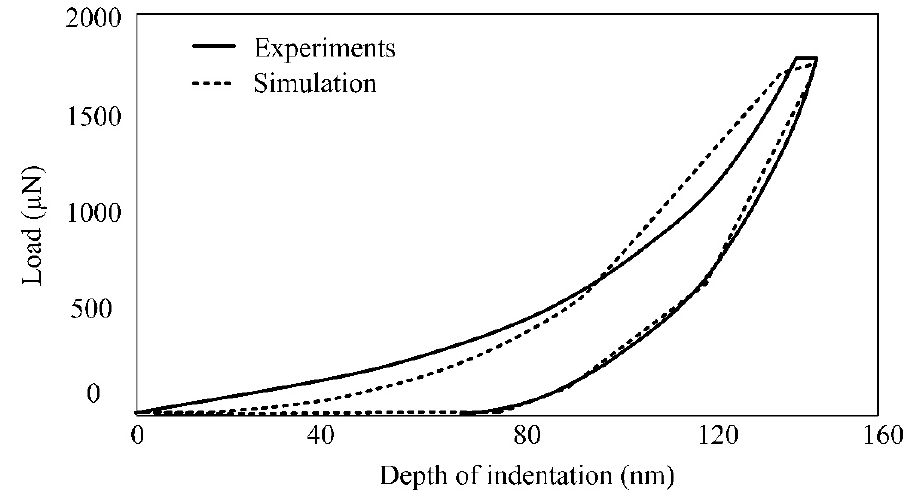
Figure 7. Load–displacement curve obtained from experimentation and simulation.